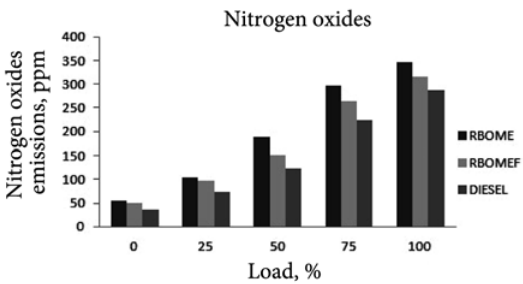
Fig. 4. NOx emission with respect to